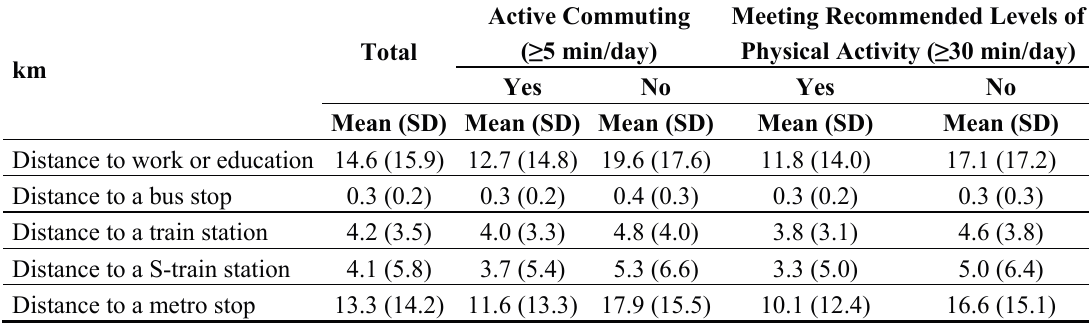
Table 3. Distance to the different public transportation modes in the population by subgroups of active commuters ( ≥ 5 min/day) (yes/no) and meeting recommendations of physical activity